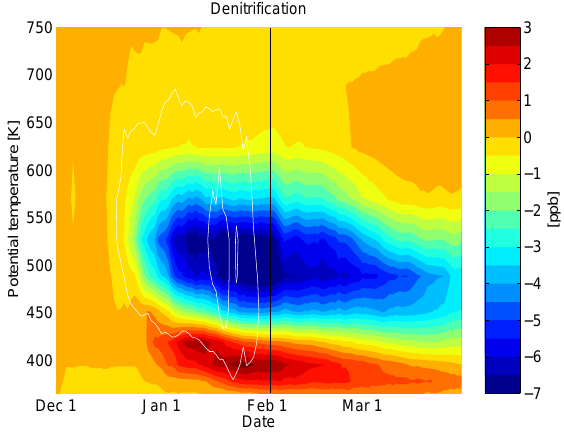
Fig. 11. Vortex-averaged denitrification for the reference run as a function of time and potential temperature. Difference between the passive NO y tracer and the modelled NO y , averaged as in Fig. 1. The thin black line shows the date of the profiles in Fig. 12. The white contours show the time periods where the formation of NAT clouds (outer contour) and ice clouds (inner contour) was possible inside the